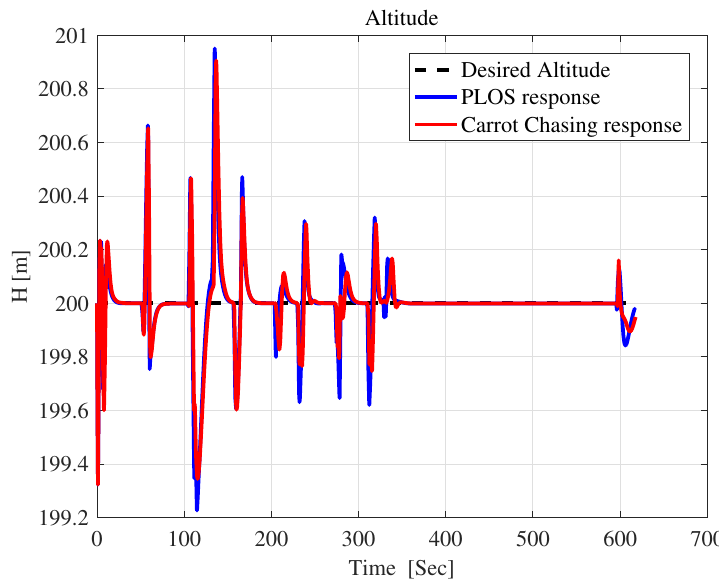
Figure 25. Altituderesponse under sharply straight line path maneuvers.